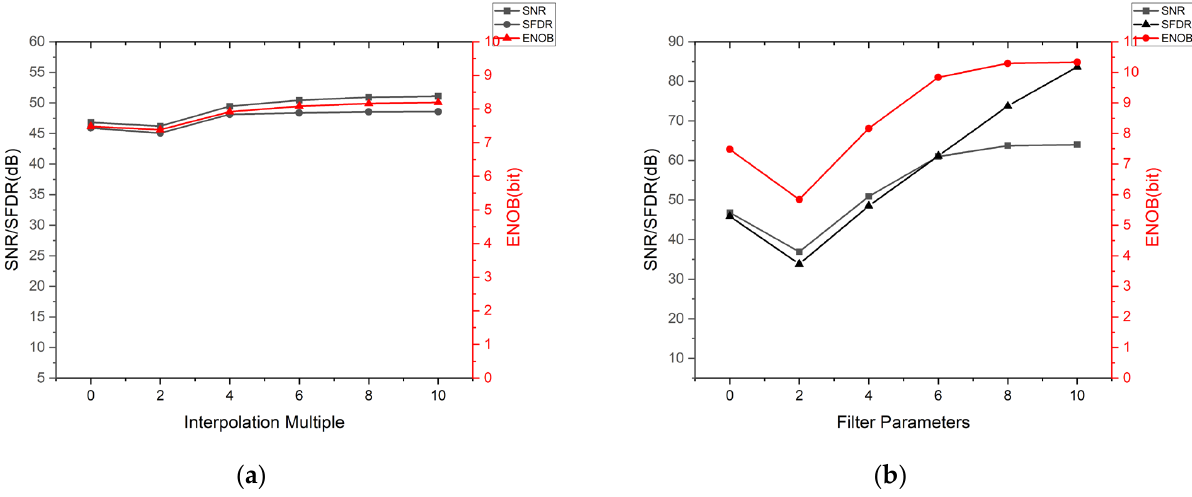
Figure 7. ( a ) Performance comparison of different interpolation multipliers under filter parameters of 4; ( b ) Performance comparison of different filter coefficients with an interpolation multiplier of 8.